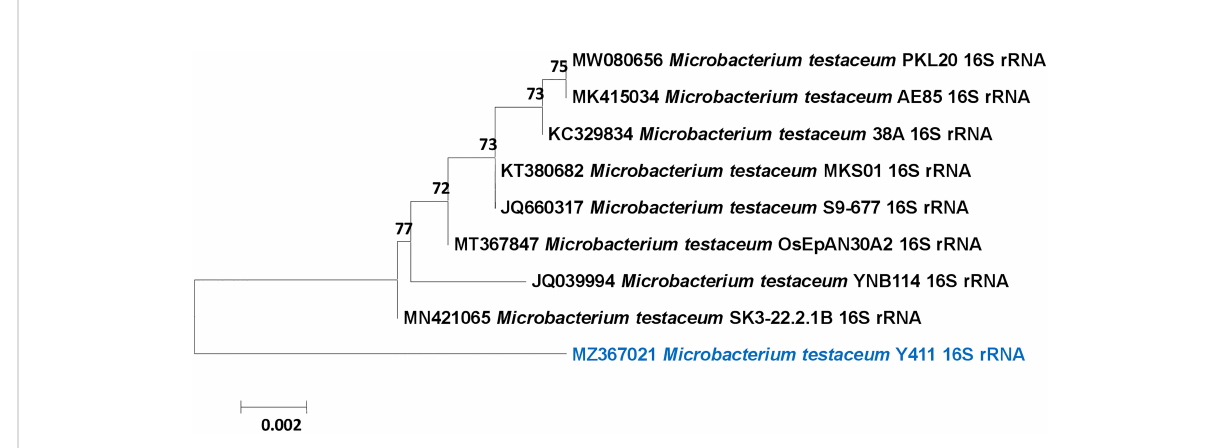
FIGURE 2 Phylogenetic tree of Microbacterium testaceum Y411 constructed using Neighbor-joining method showing the relationships among the 16S rRNA gene sequence of NCBI database.